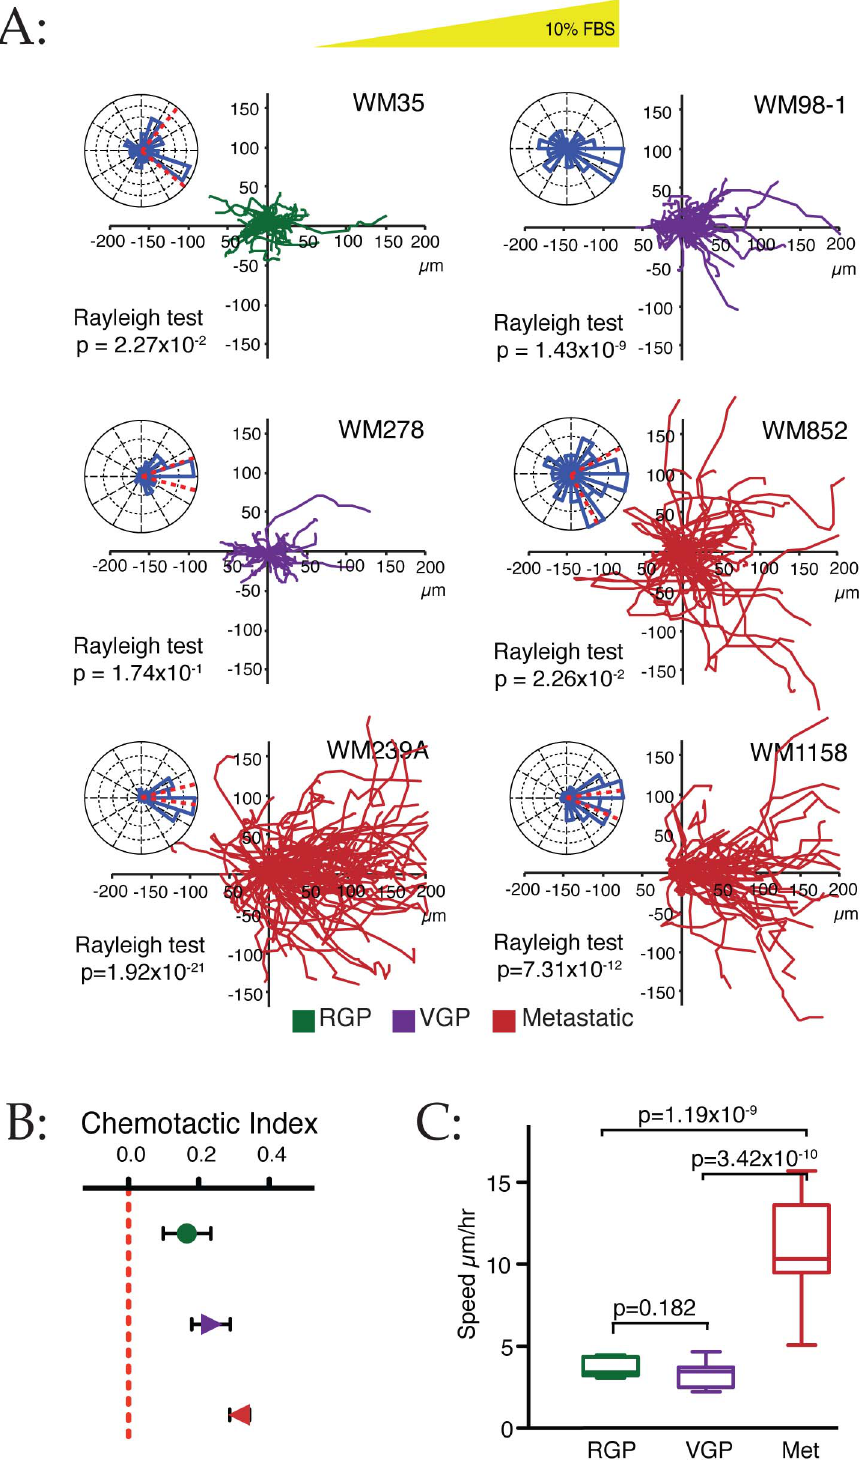
Figure 3. Chemotaxis of cells from different melanoma stages. (A) Chemotaxis of a panel of six cell lines from different melanoma stages (RGP, green; VGP, purple; metastatic, red) up a 0%–10% FBS gradient was measured as above ( n $ 45 cells per cell line). (B) Chemotactic index of cells from different stages. Data from (A) were collated by melanoma stage. Chemotaxis improves as the stage of melanoma progresses, although even the earliest RGP cells show clear chemotaxis. (C) Speeds of cells from different stages. Data from (A) were collated by melanoma stage. Metastatic lines are conspicuously faster ( p -values from unpaired t -tests), although again the speed of RGP and VGP cells is still relatively high for non- haematopoietic cells.